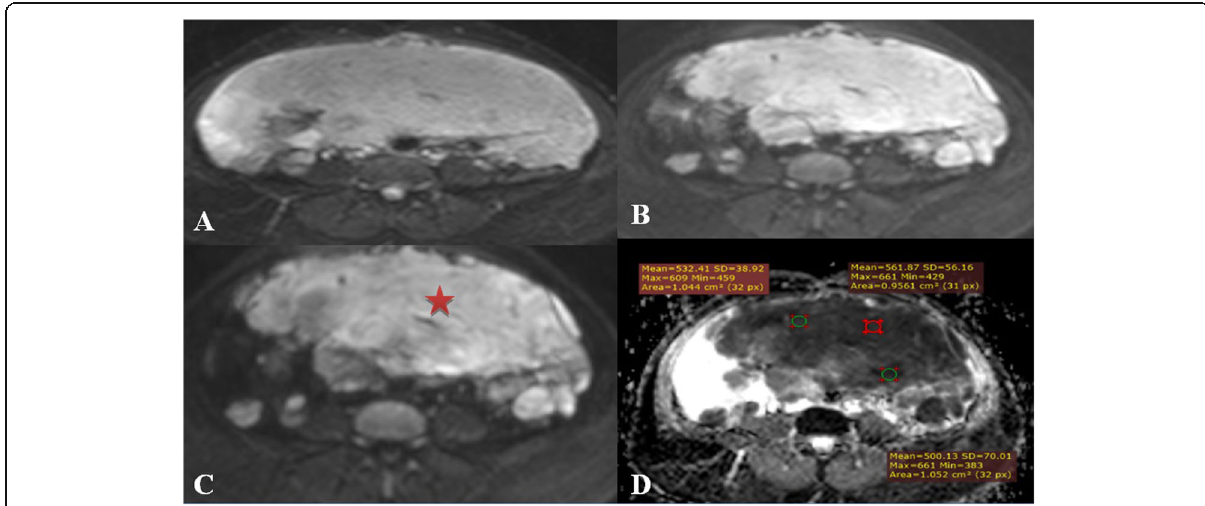
Fig. 2 Thirty-five year old female patient presented with chronic abdominal pain and loss of weight. a DWI at b 0. b DWI at b 500. c DWI at b 1000. d ADC map. The images showed sheets of peritoneal thickening (arrow) with high signal in DWI and low in ADC map, impressive of